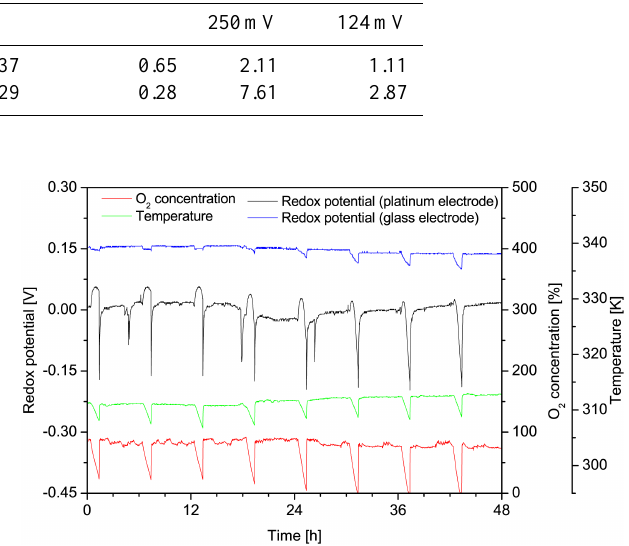
Figure 4. Influence of the air cleaning every 12h on the parameters redox potential, pH value and temperature during a measurement in the process water of a paper industry.